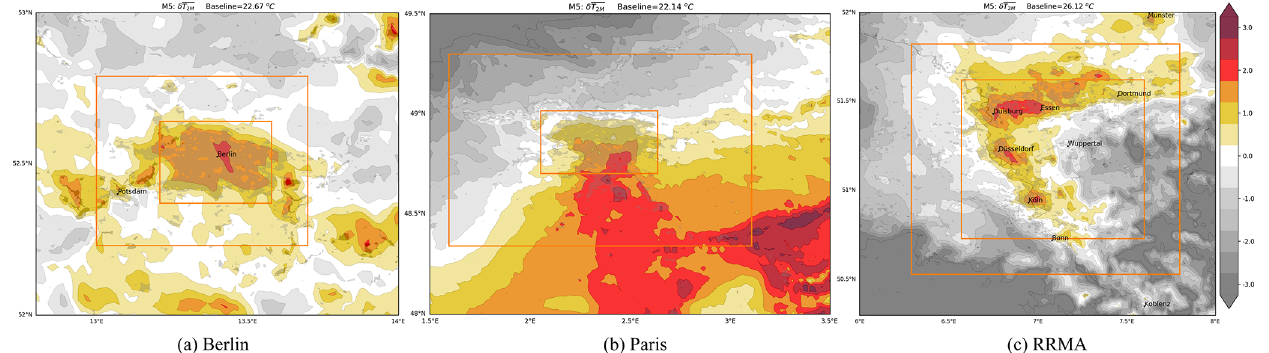
Figure A2. UHI calculated with M5 on the original grid (no interpolation) for Berlin, Paris and the Rhine-Ruhr Metropolitan Area (a–c) , the rural area used as baseline is encompassed by the two orange rectangles, or in Fig. 1 as the orange grid-points.